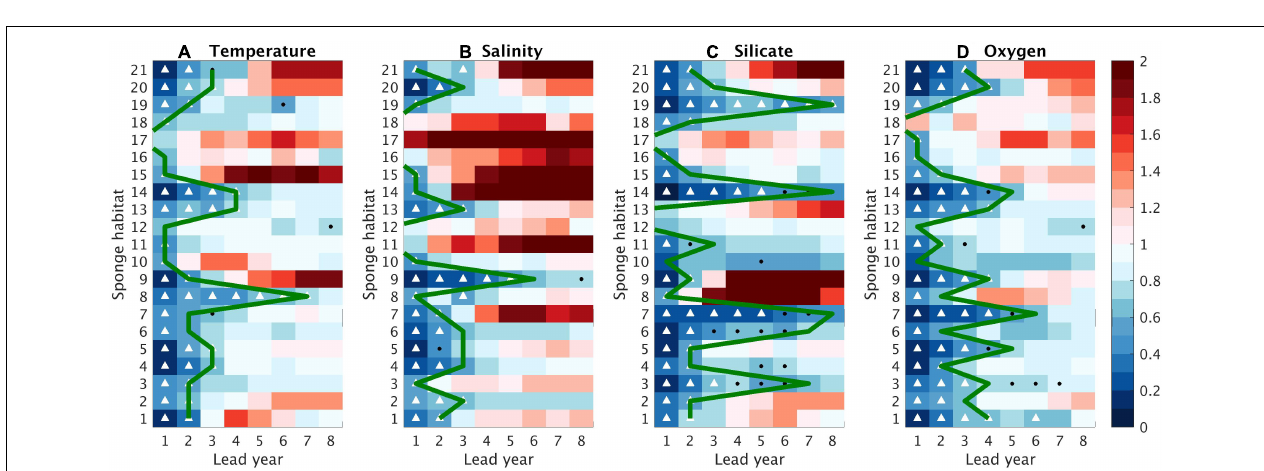
FIGURE 9 | Normalized mean absolute errors (NMAEs) as a function of lead time ( x axis) and sponge habitat ( y axis) for (A) Temperature, (B) Salinity, (C) Silicate, and (D) Oxygen. White triangles indicate that the NMAEs are significantly smaller than 1 and significantly smaller than the NMAEs with the uninitialized simulations; black dots denote that the NMAEs are significantly smaller than 1but not significantly smaller than the uninitialized simulations. NMAE > 1 is considered as no predictability. Green lines, identical with the green lines in Figure 8 , indicate the predictability horizon, which is defined as the last lead year when ACCs are significant and the NMAEs are significantly smaller than 1. Significance is tested based on a bootstrap approach with 500 bootstrapped